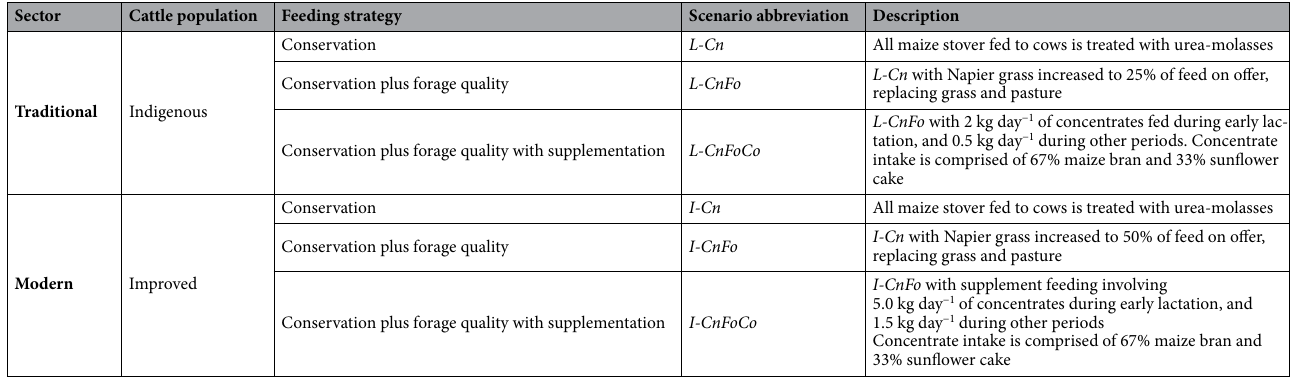
Table 2. Definitions of scenarios examined and their target populations of